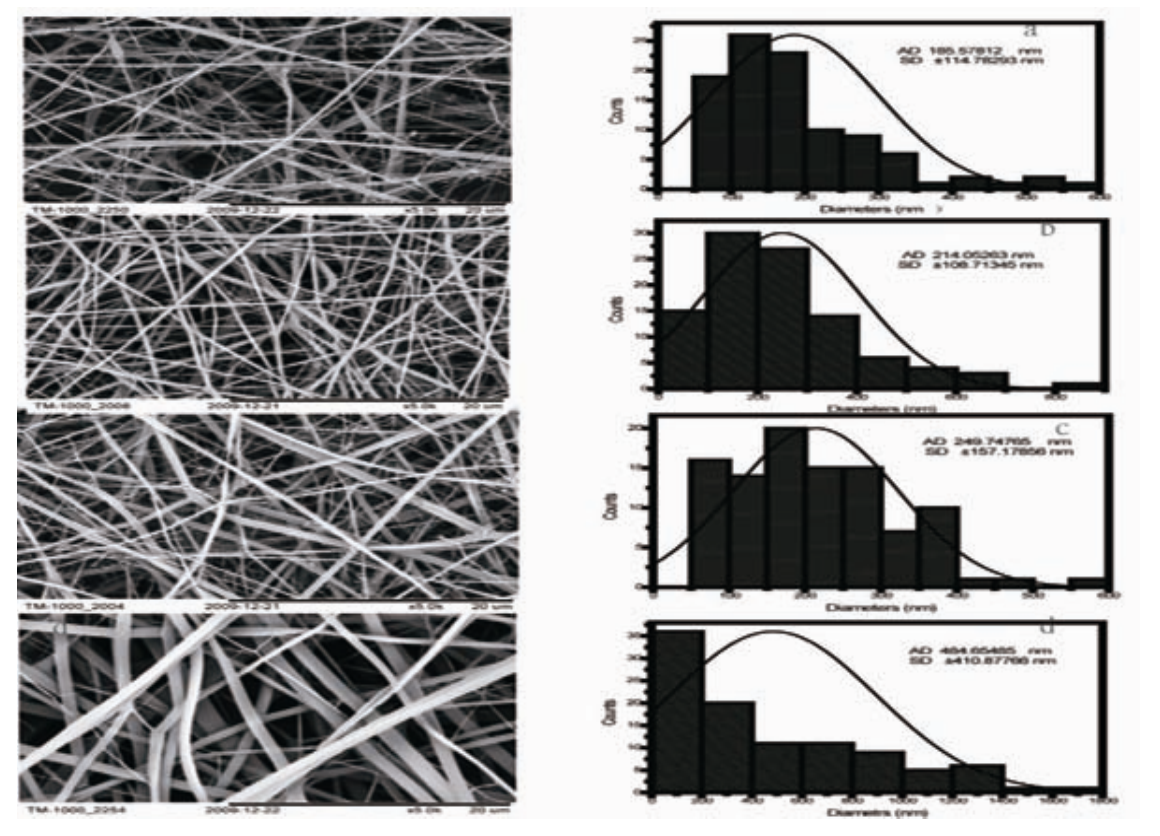
Figure 1. SEM micrographs of electrospun CS/SF blend fibers: ( a ) CS/SF (80/20); ( b ) CS/SF (50/50); ( c ) CS/SF (20/80); ( d ) pure